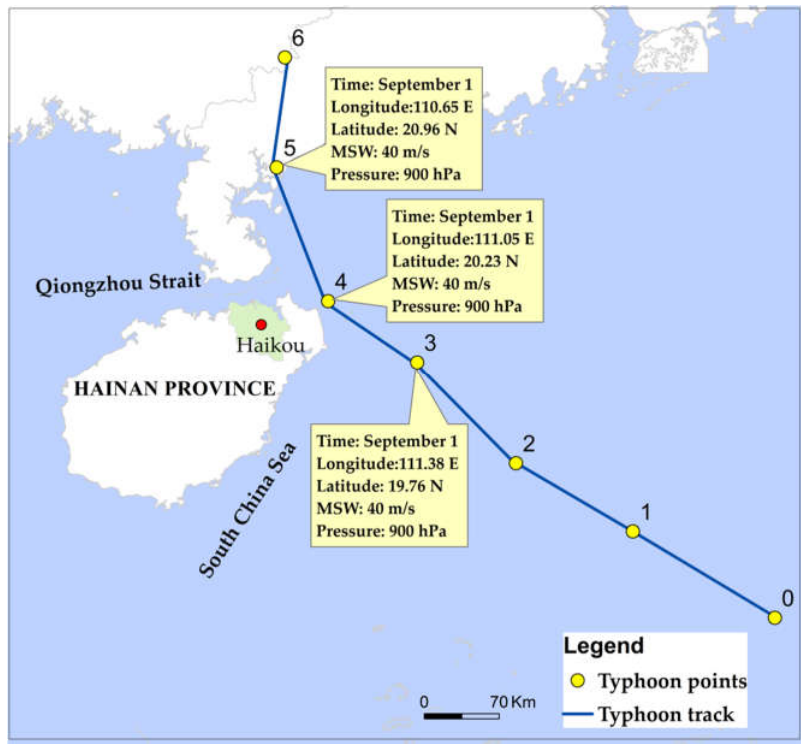
Figure 3. An example of a typhoon track affecting Haikou.